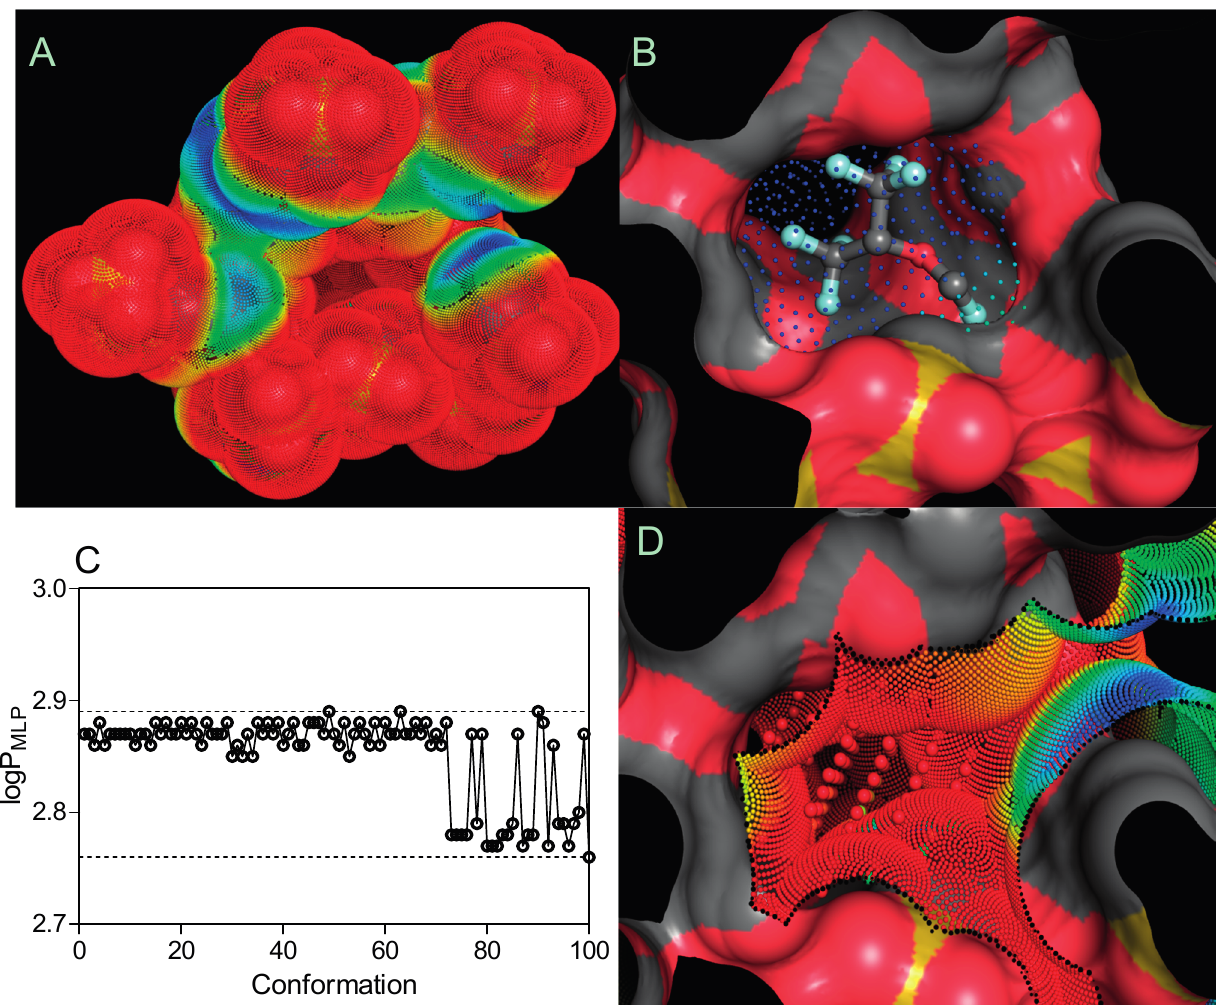
Figure 7. Three-dimensional models of the SBE 7 β CD ( A ) structure and SEV-SBE 7 β CD ( B ) complex (obtained by molecular docking) with MLP-surfaces around the cyclodextrin molecule and best conformational pose (cluster with RMSD values of 2 Å) of the ligand. logP MLP ( C ) and MLP-Pocket ( D ) display the distribution of lipophilicity for the SBE 7 β CD binding site and pose conformations of sevoflurane. The thresholds are depicted as dashed lines. MLP calculated as hydrophobic fitting points depicted in smaller colored spheres according to the MLP range from red (the most polar points) to blue (the most hydrophobic points). MLP-pocket in the center of the center of SBE 7 β CD molecule is depicted in bigger colored spheres. Molecular surface was calculated to visualize the cyclodextrin cavity. The ball-and-stick SEV model is colored according to its atomic composition. Hydrogen atoms are omitted to enhance